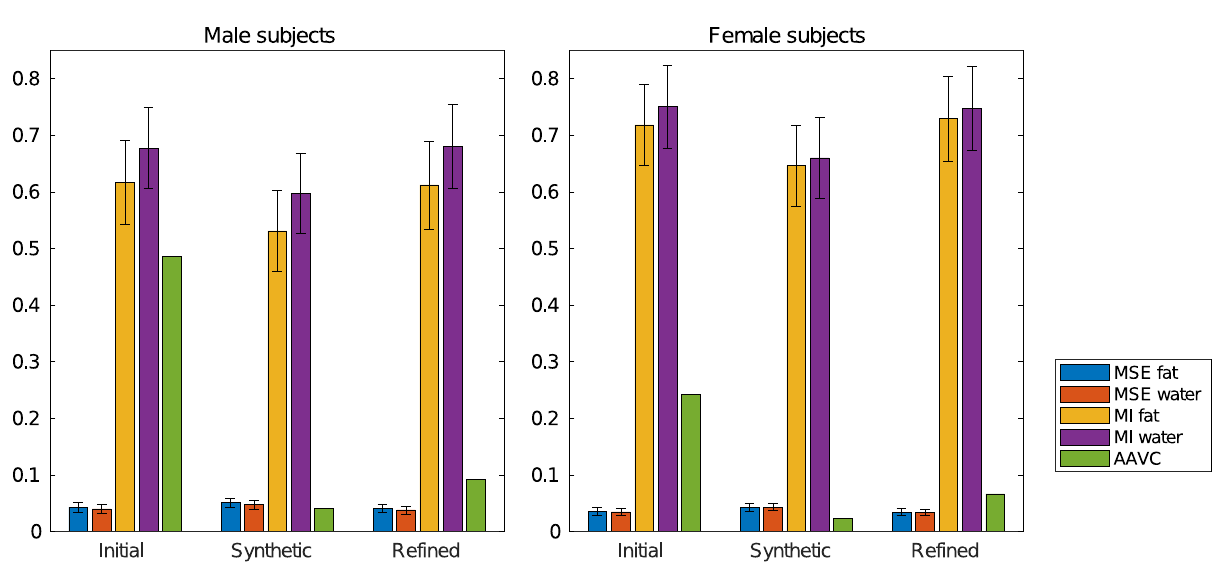
Fig 3. Generation of the synthetic reference for the registration of two different cohorts. Plot of the average absolute volume change (AAVC) as defined in Eq 3, and of the mean and variance across the cohort of mean squared error (MSE) and mutual information (MI) for the registration on the initial reference, the result on the synthetic reference, and a further refined registration on the synthetic reference. The data for each subject is reported in S1 and S2 Files.